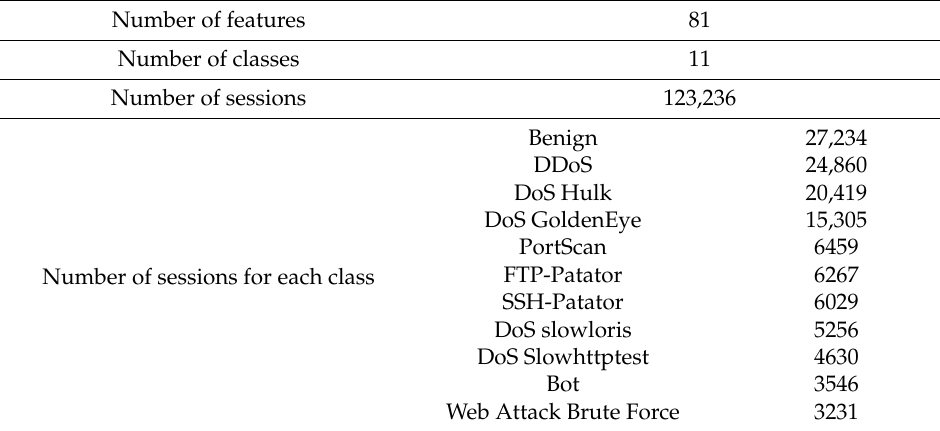
Table 6. Details of the CIC-IDS2017 dataset.